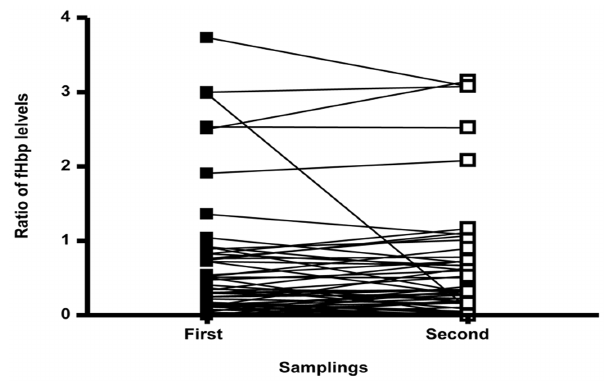
Figure 2. Schematic representation of the levels of expression of fHbp overtime among carriage isolates. Data were obtained from 80 subjects for whom two positive pharyngeal swabs were available at a mean of 1 weak interval. For each subject, the data were expressed as ratio of the expression of fHbp from the fist sample and the reference isolate and linked by a solid line to the ratio of the expression of fHbp from the second sample and the reference isolate.